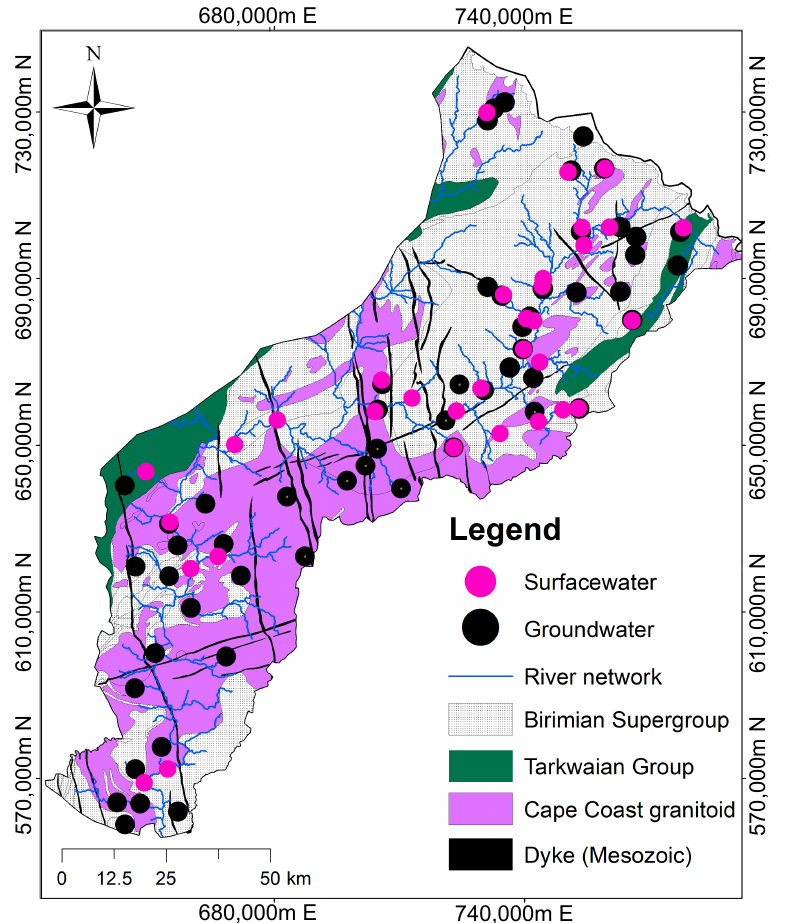
Figure 2. Geological map of the study area showing the predominant rock types and the sampling locations. The Birimian Supergroup consist of meta-sediments, mainly phyllite, schists and greywacke. The Tarkwain Group consist of sandstones, conglomerates and argillites, the Cape Coast granitoid of quartz and dioritic gneiss and the Dyke is made of